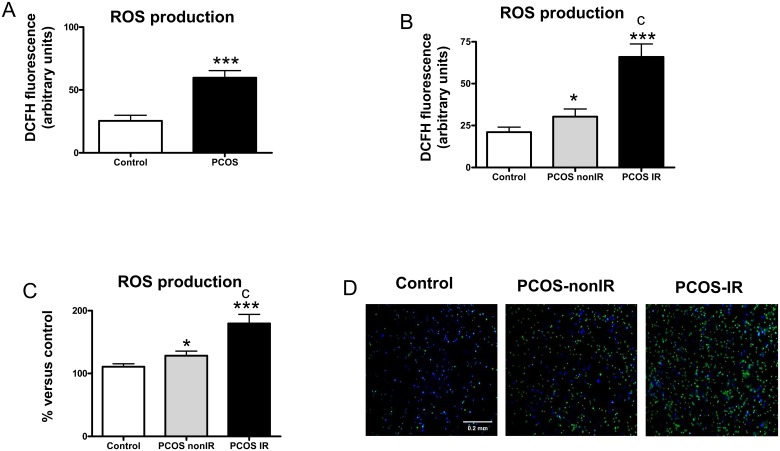
Effects of PCOS on levels of ROS in PMN.(A) Levels of DCFH-DA fluorescence measured by fluorimetry in controls and PCOS subjects; (B) Levels of DCFH fluorescence in controls and in PCOS non-IR and PCOS IR subjects; (C) Mean DCFH fluorescence assessed by static cytometry; % vs control. (D) Representative images of DCFH-DA fluorescence in PMNs assessed by fluorescence microscopy; nuclei: Hoechst 33342 signal (blue); ROS: DCFH-DA signal (green). *p<0.05 ***p<0.001 vs. Control; cp<0.001 between PCOS non-IR and PCOS IR subjects.